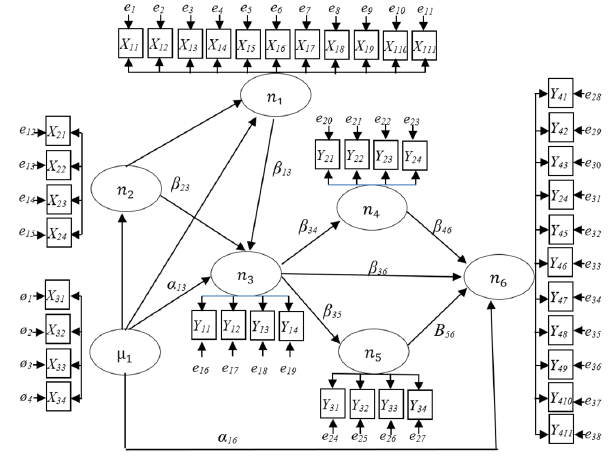
Fig. 3. Path diagram of citizen science for smart economy